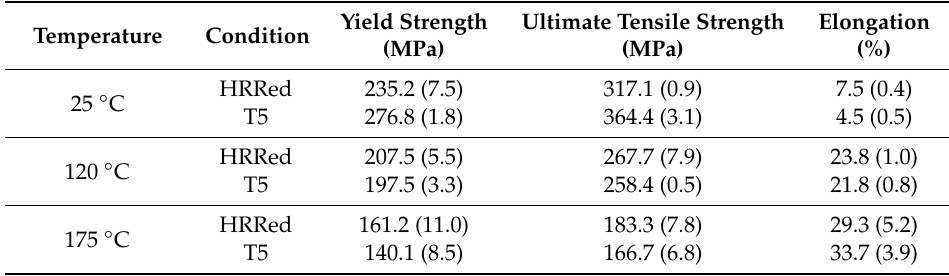
Figure 3. Tensile curves of HRRed and T5 specimens tested at di ff erent temperatures. ( a ) 25 ◦ C; ( b ) 120 ◦ C; ( c ) 175 ◦ C. Table 1. Tensile properties of HRRed and T5 specimens tested at di ff erent temperatures (standard deviation is given in